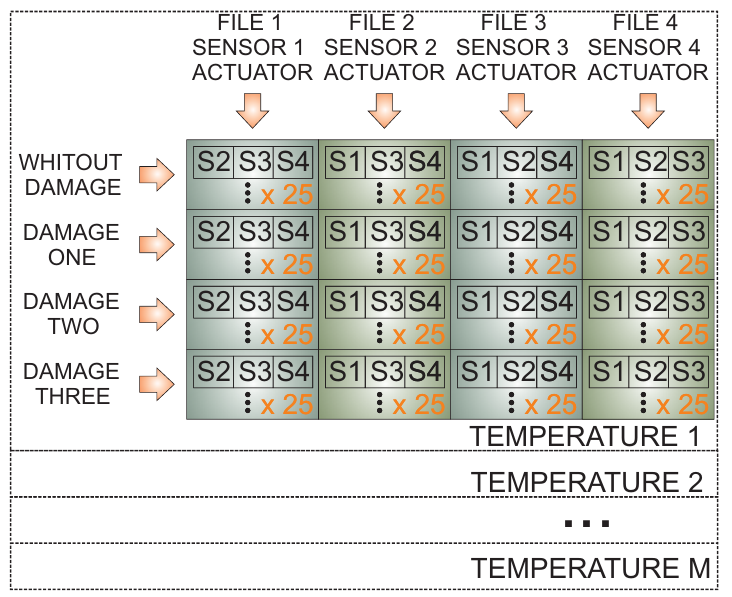
Figure 5. Data organization per each temperature.